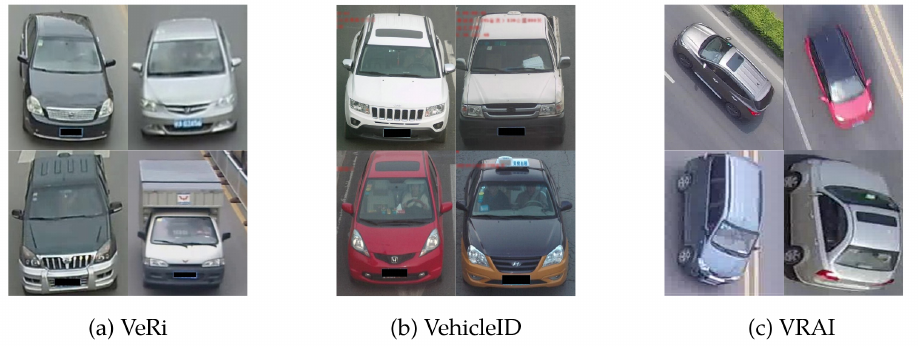
Figure 4. Samples from different